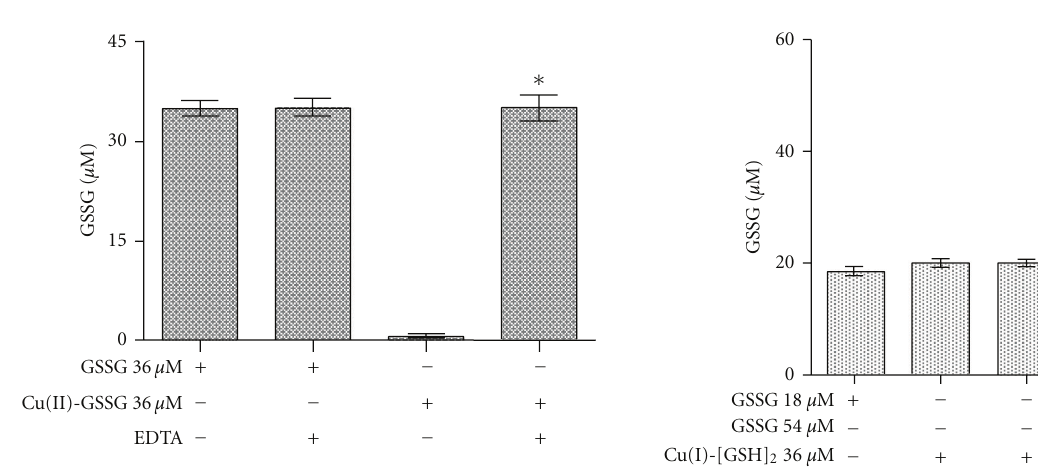
Figure 3: E ff ect of EDTA on the recovery of GSSG from the Cu(II)- GSSG complex assayed by the NADPH/glutathione reductase assay. NADPH (0.2mM), glutathione reductase (2U/mL), and EDTA (2mM) were added to a solution containing GSSG (36 μ M) or a preformed Cu(II)-GSSG complex (36 μ M). The decrease in OD 340nm was registered and the results expressed as μ M GSSG concentration. The asterisk on the bars indicate that such values are statistically di ff erent, at the level of a P < 0 . 001, from all other values.